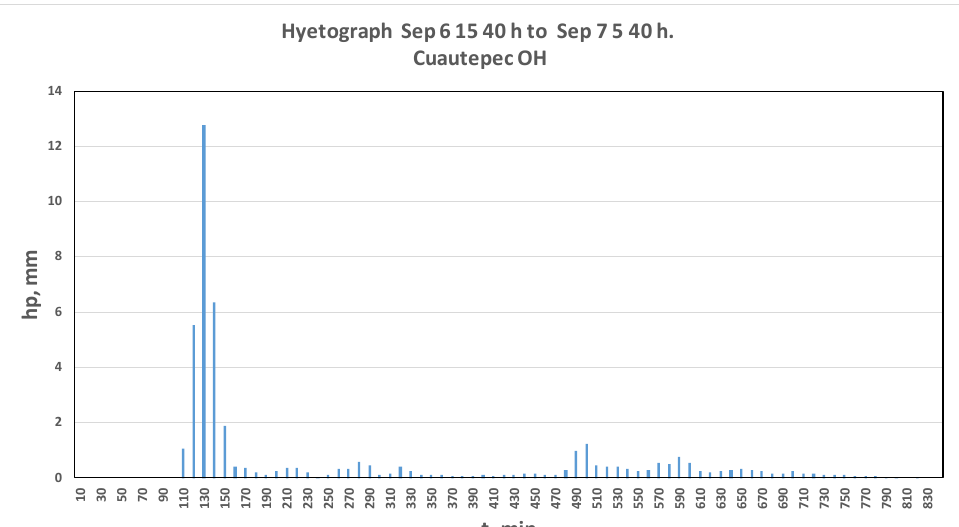
Figure 4. Coefficients map of variation for historical annual maximum daily rainfall in Mexico Val ‐ ley. “Adapted from Ref. [21], 2022, SACMEX”.